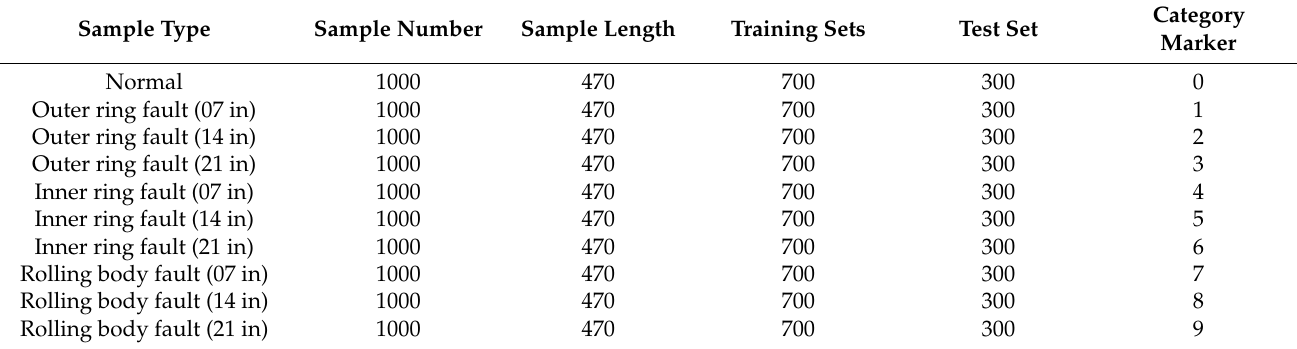
Table 2. Open CWRU bearing data set